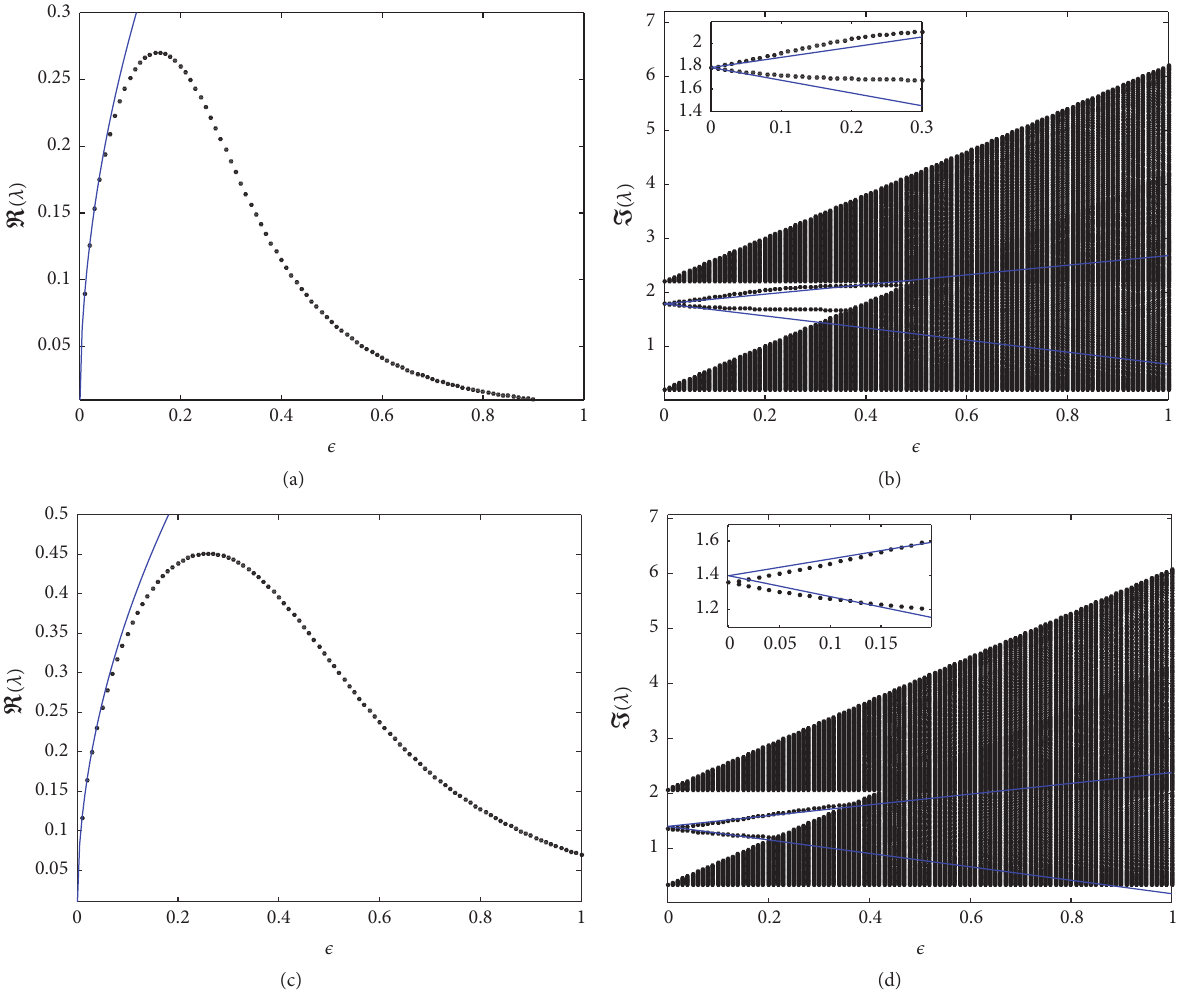
Figure 1: Eigenvalues of intersite soliton I with 𝜔 = 1.2 , 𝛾 = 0 (a, b) and 0.5 (c, d). Dots are from the numerics and solid lines are the asymptotic approximations in Section 4.2.1. The collection of dots forming black regions in the right column corresponds to the continuous spectrum.